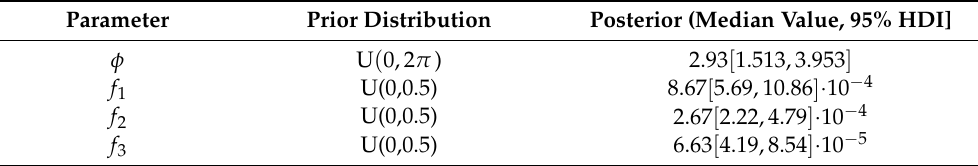
Table 2. Estimated parameters. In each realization of our simulation, the four parameters were drawn from the joint probability distribution, which was evaluated using the Monte Carlo Markov Chain